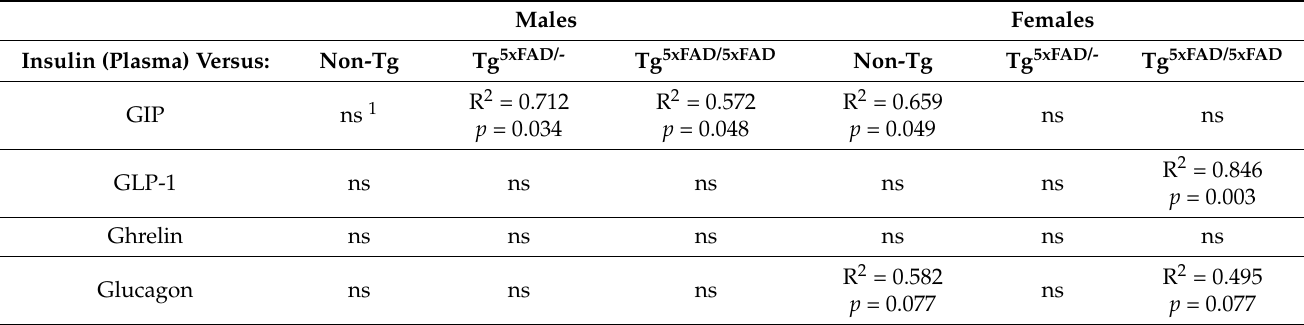
Table 3. Correlations between plasma insulin and insulin release-regulating hormones in 5xFAD mice at 6 months of